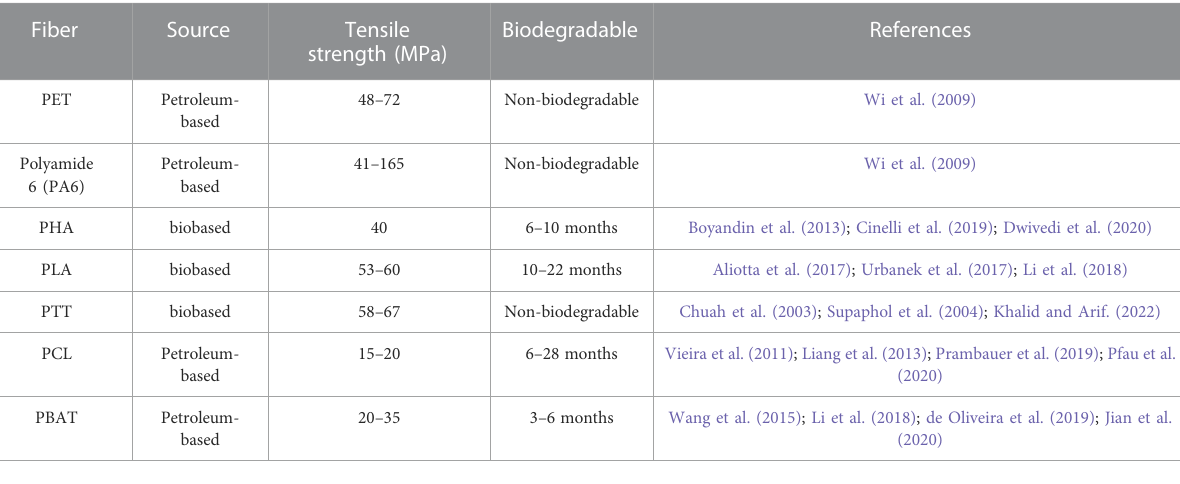
TABLE 1 Tensile strength and biodegradability of various fi bers.